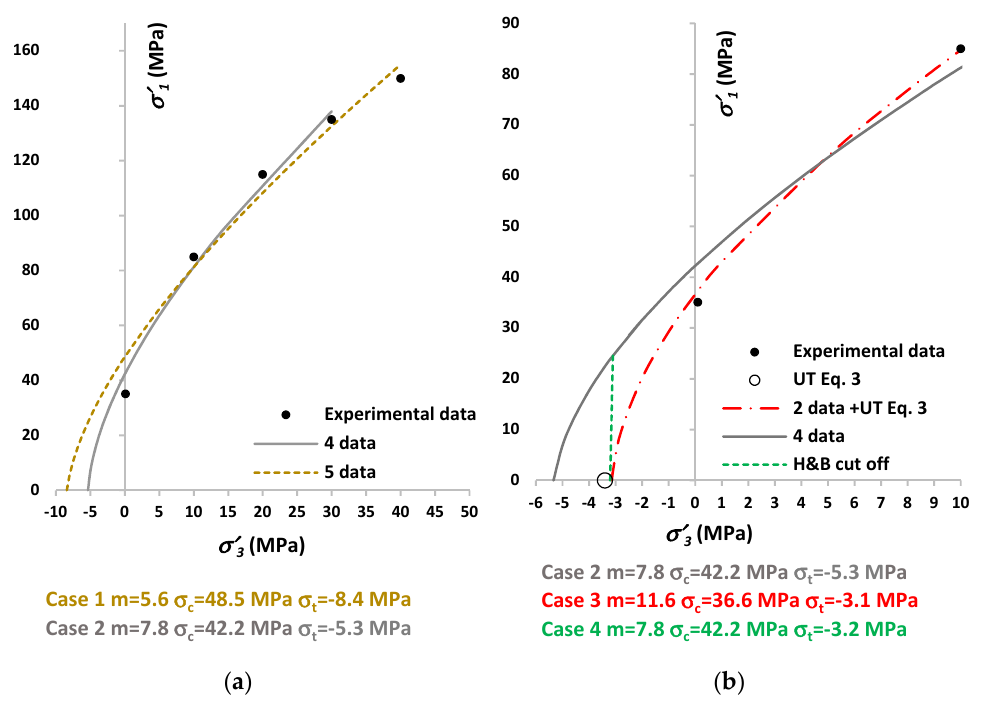
Figure 2. ( a ) Comparison of data fitting of triaxial compression tests of Vosges sandstone with a confinement range σ ′ 3 = 0.1–40 MPa and σ ′ 3 = 0.1–30 MPa. ( b ) Comparison of data fitting with confinement range σ ′ 3 = 0.1–30 MPa (grey line) and σ ′ 3 = − 3.4–10 MPa (red line). The open symbol, UT Equation (3), is the uniaxial tensile strength estimated with Equation (3). The green line is the tensile cut off calculated with σ c / σ t = 0.81 m + 7.